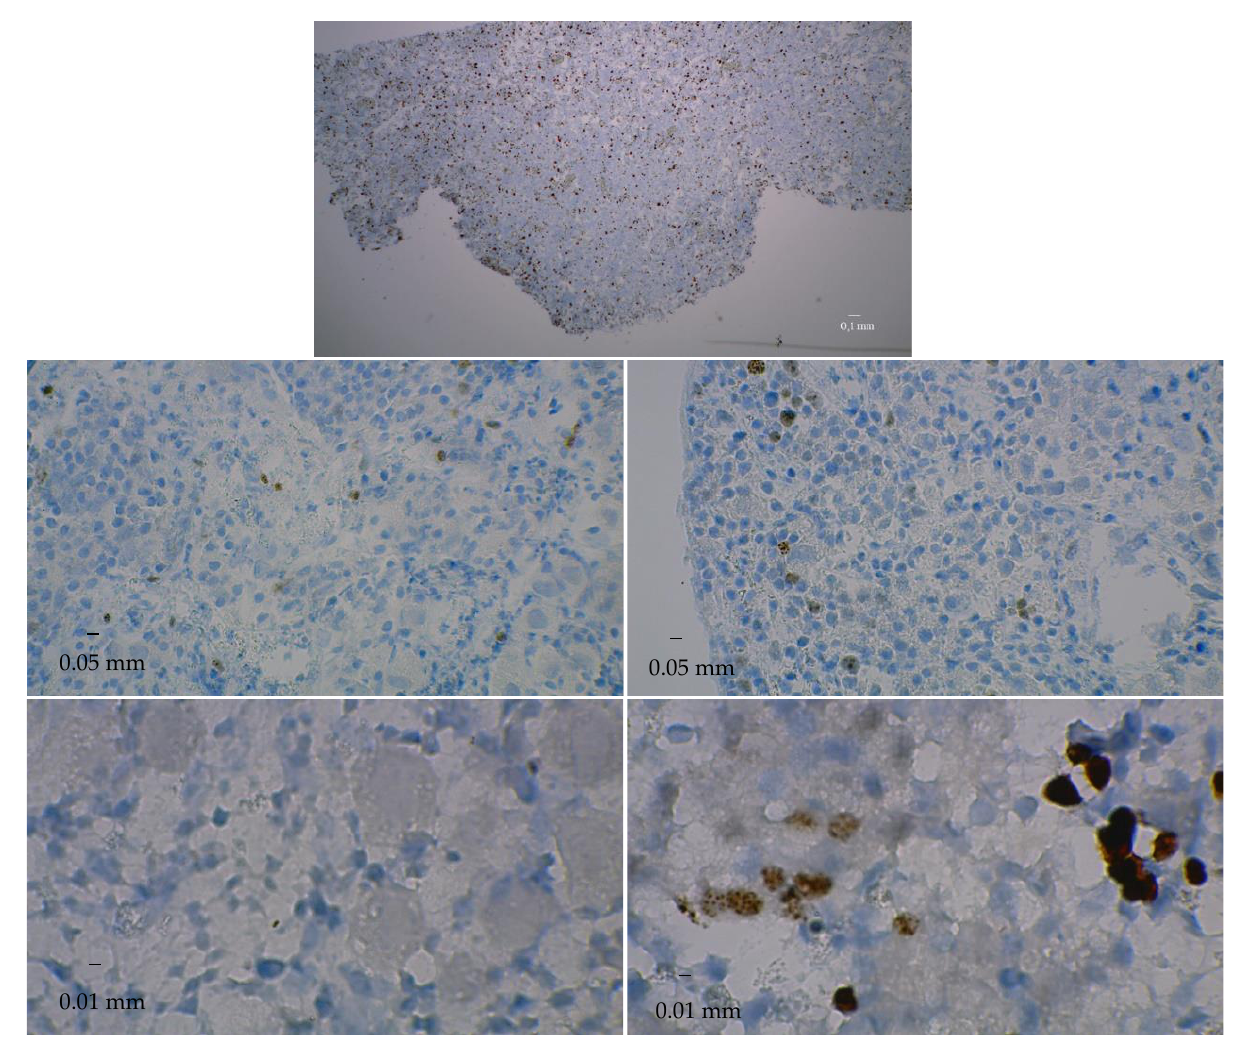
Figure 6. Ki67 immunostaining. Upper panel: Slice of fresh fetal ovarian tissue before culture. Middle row: Slices at day 50 of culture. Lower row: Slices at day 90 of culture. Left panels: control cultures. Right panels: bioreactor cultures. Positive (proliferating) cells have a brown color.